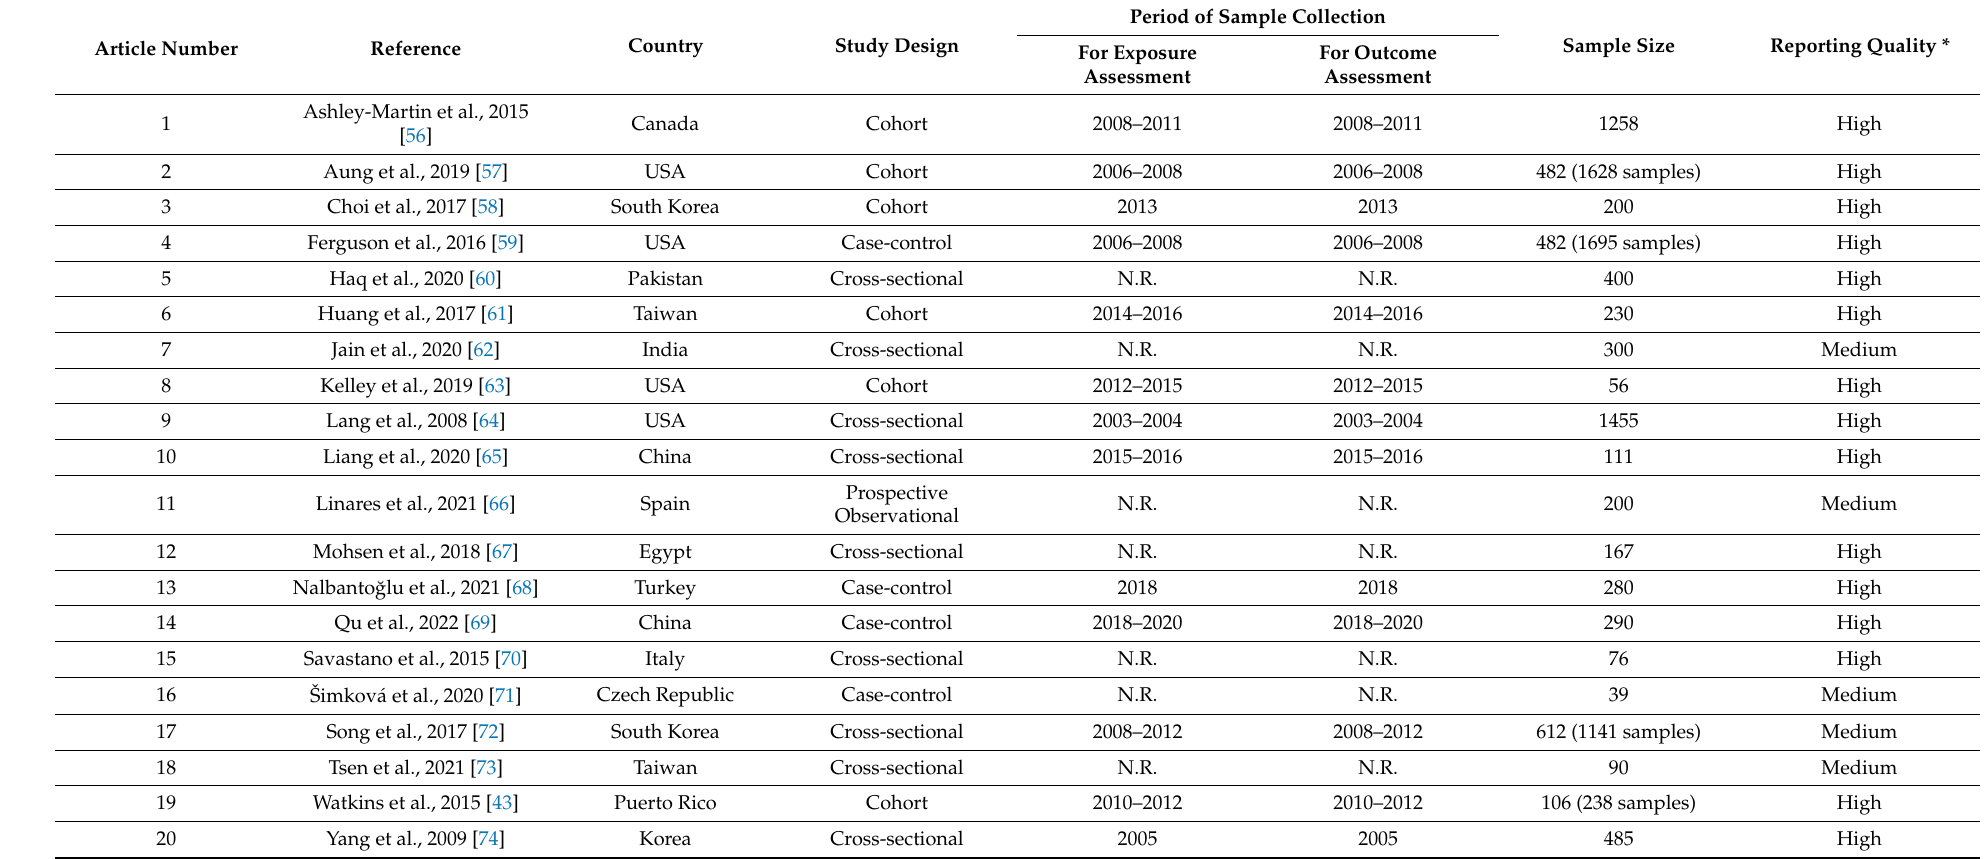
Table 1. General characteristics of the studies included in this systematic